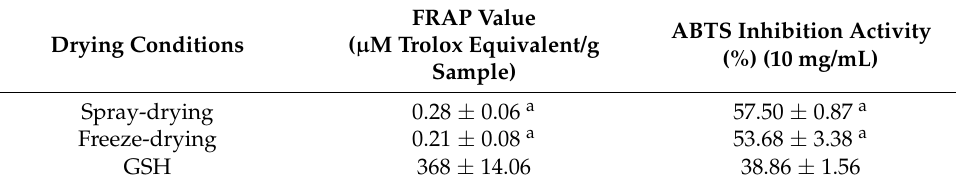
Different letters in the same row indicated significantly difference at p < 0.05. 1 Values are expressed as mean ± standard deviation at p < 0.05. 2 GSH refers to L-glutathione at 0.1